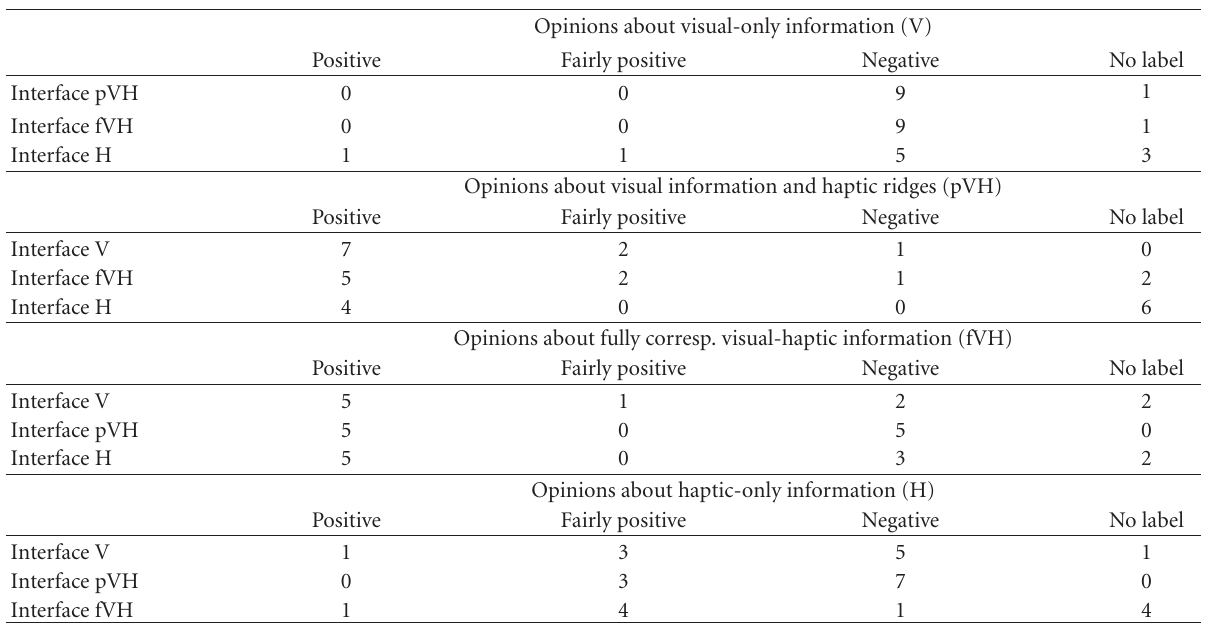
Table 5: Answer incidences for interface